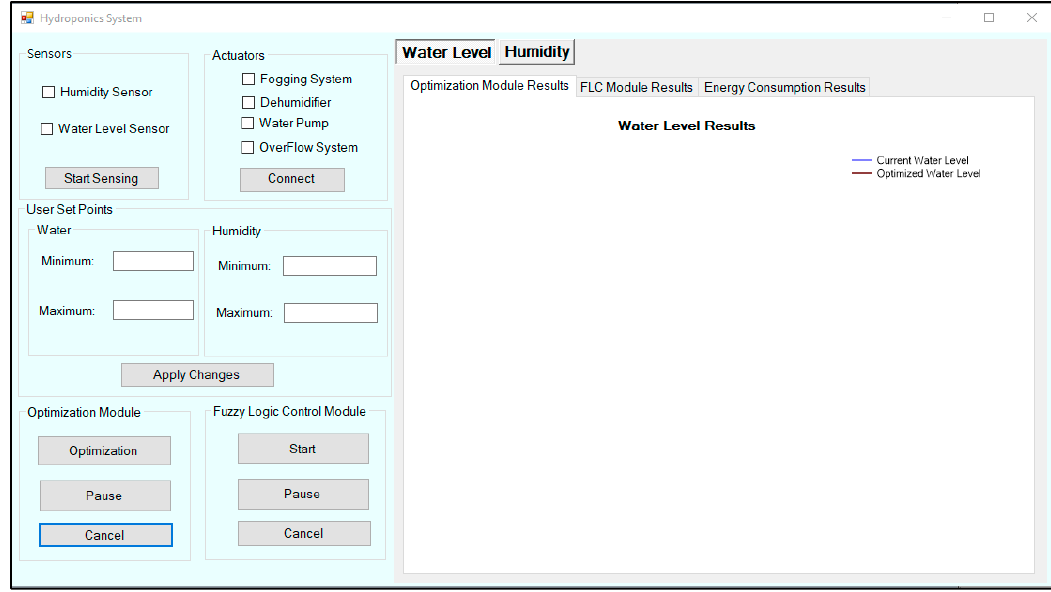
Figure 10. The hydroponics simulator interface.